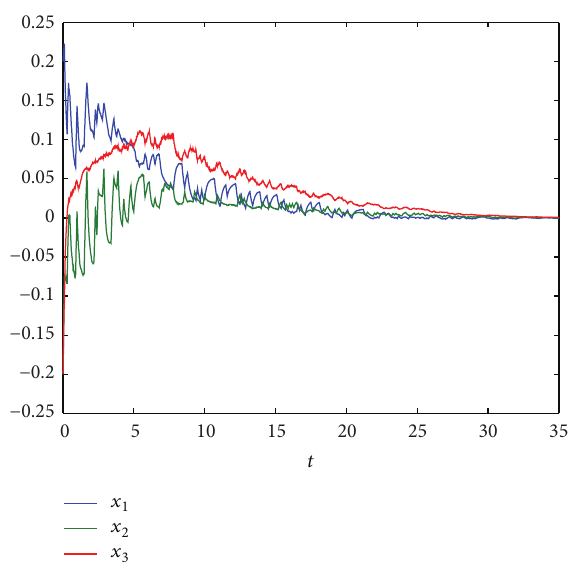
Figure 4: State response of the neural network under the Markov chain depicted in Figure 3 in Example